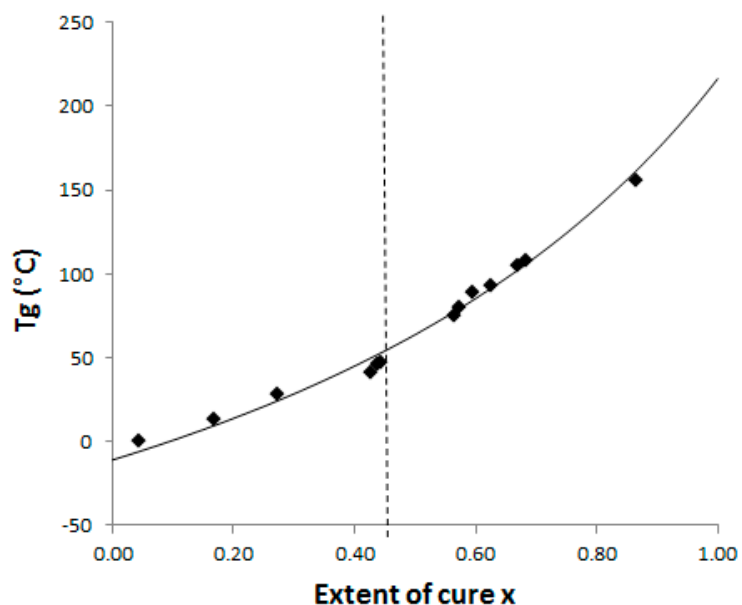
Figure 4. CTT phase diagram: dash line = gelation and full line = Di Benedetto curve glass transition temperature versus conversion for the neat epoxy-amine system; : Experimental points. The values of T g and Δ C p for x = 0 (measured) and x = 1 (calculated) are listed in Table 1. Very close values for Δ C p0 were already found by Girard-Reydet and al. [28] and Eloundou and al. [29] ( Δ C p0 = 0.54 J·g − 1 ·K − 1 ). Nevertheless, Δ C p ∞ values differ (as the authors reported 0.19 J·g − 1 ·K − 1 ). Such discrepancies could be attributed to the stoichiometric ratio, r = 0.9 considered in this work, introducing some dangling chain ends. Table 1. Glass transition and isobaric calorific capacity values for the neat epoxy-amine system at x = 0 and x = 1.